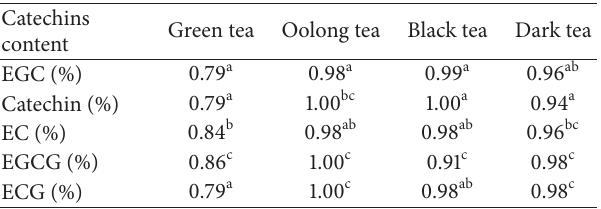
Table 5: Correlation coefficients between AE and catechins content in different tea infusions